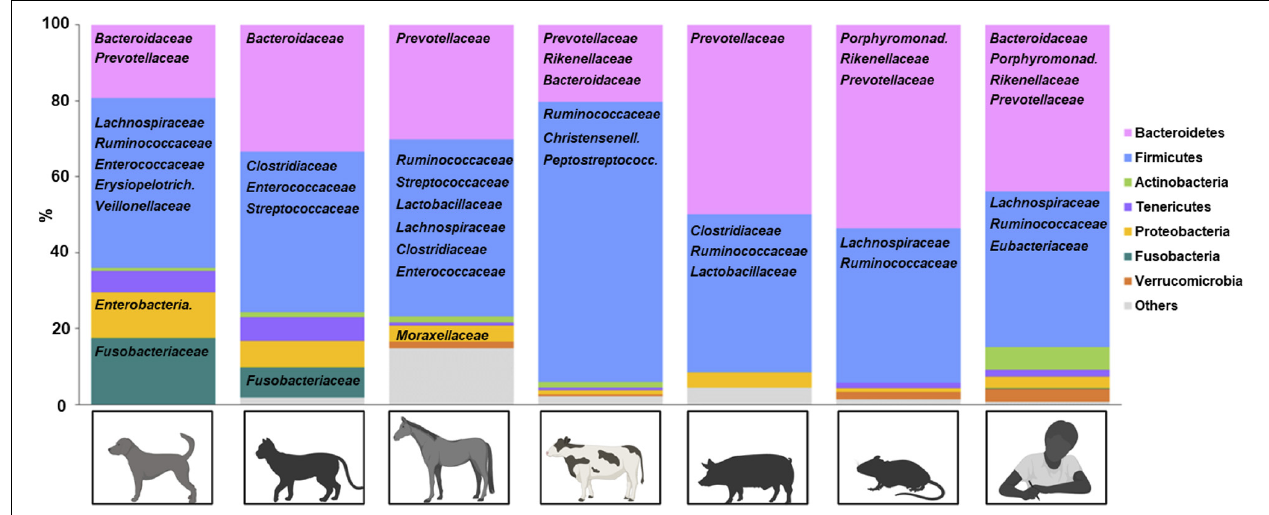
FIGURE 1 | Representative fecal microbiota of healthy domestic animals. Phyla are represented by color and bacteria (family level) are represented below the corresponding phylum. Created with